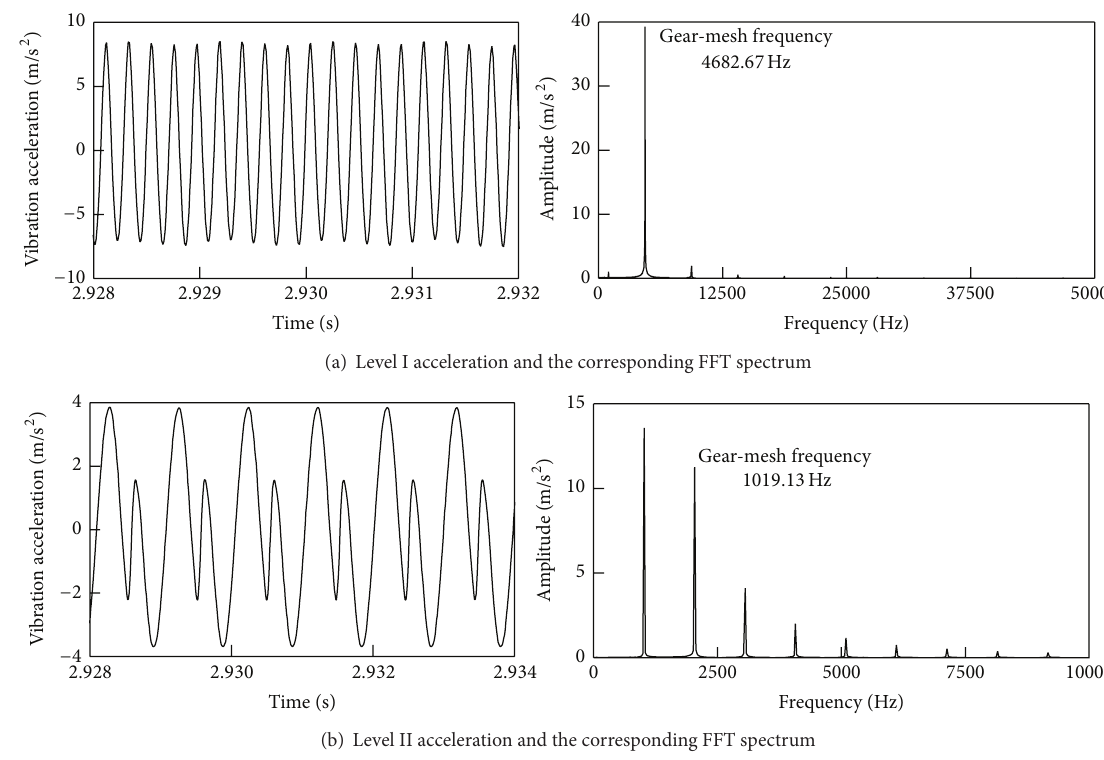
Figure 10: Vibration acceleration time history and FFT spectrum under standard conditions.